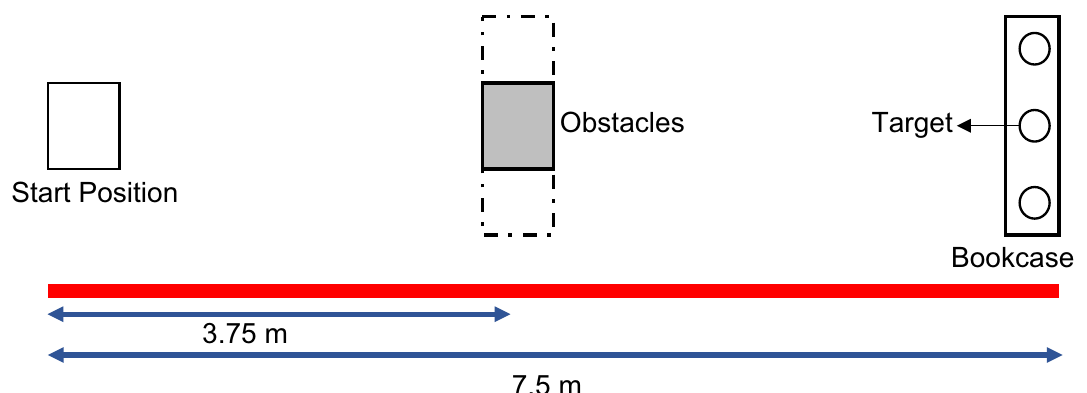
Figure 1. Experimental setup. Participants walked 7.5 m to a bookcase that had an empty 16 oz cup (the “target”) sitting on its lower shelf (.88 m from the floor).